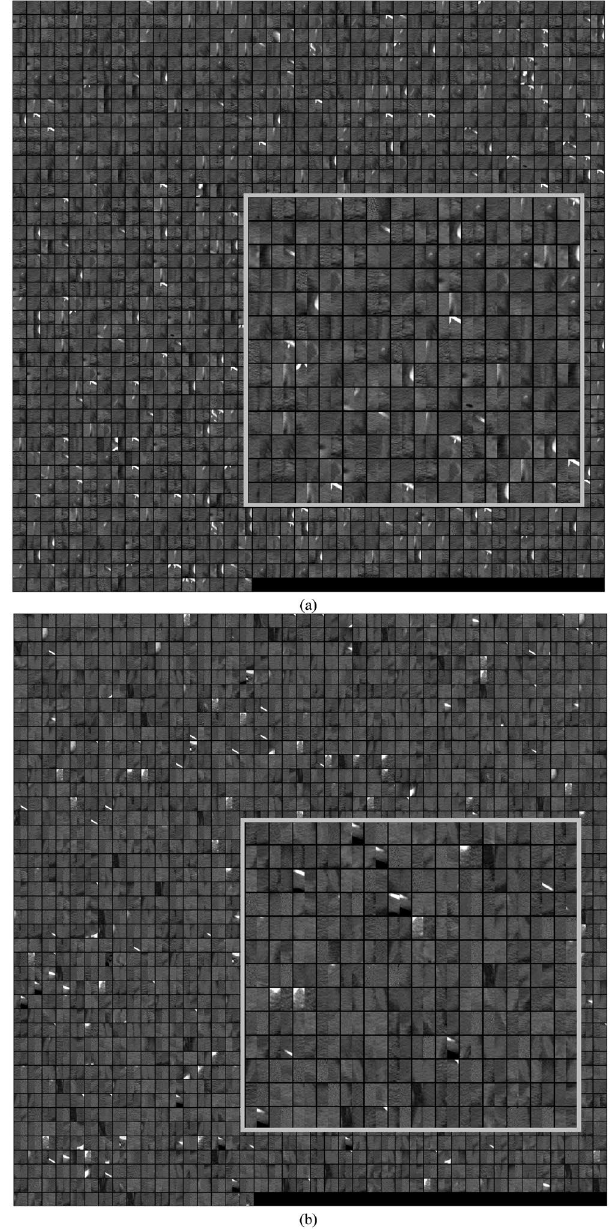
Figure 3. Subset of Paired ROIs used to train the DL-CNN. Each ROI is 32 × 32 pixels. ( a ) ROIs that were labeled as being stage T0 after treatment. ( b ) ROIs that were labeled as being greater than stage T0 after treatment. A portion of ROIs in each class is zoomed in to illustrate the content of typical